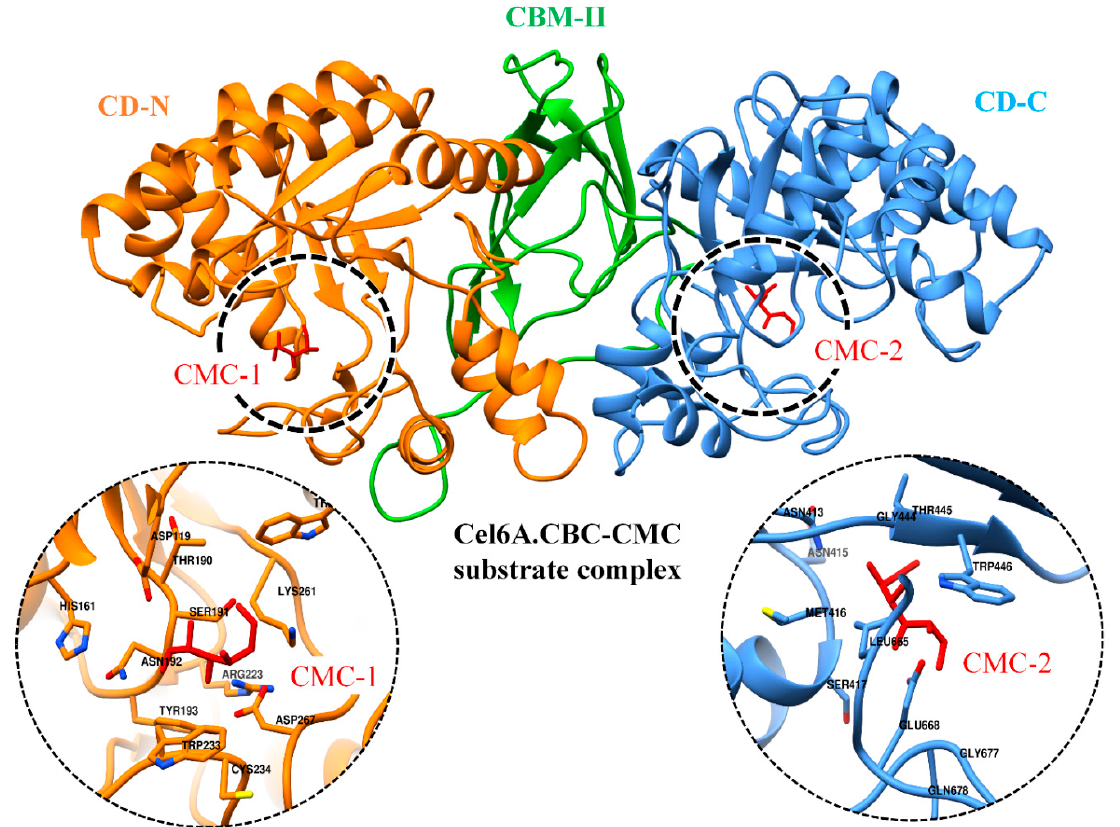
Figure 7. Docked conformation of CMC substrates (red sticks) as CMC1 and CMC2 with N and C-terminal catalytic domains of Cel6A.CBC, respectively. The zoomed-in on left and right displaying the binding site residues in respective catalytic domains.